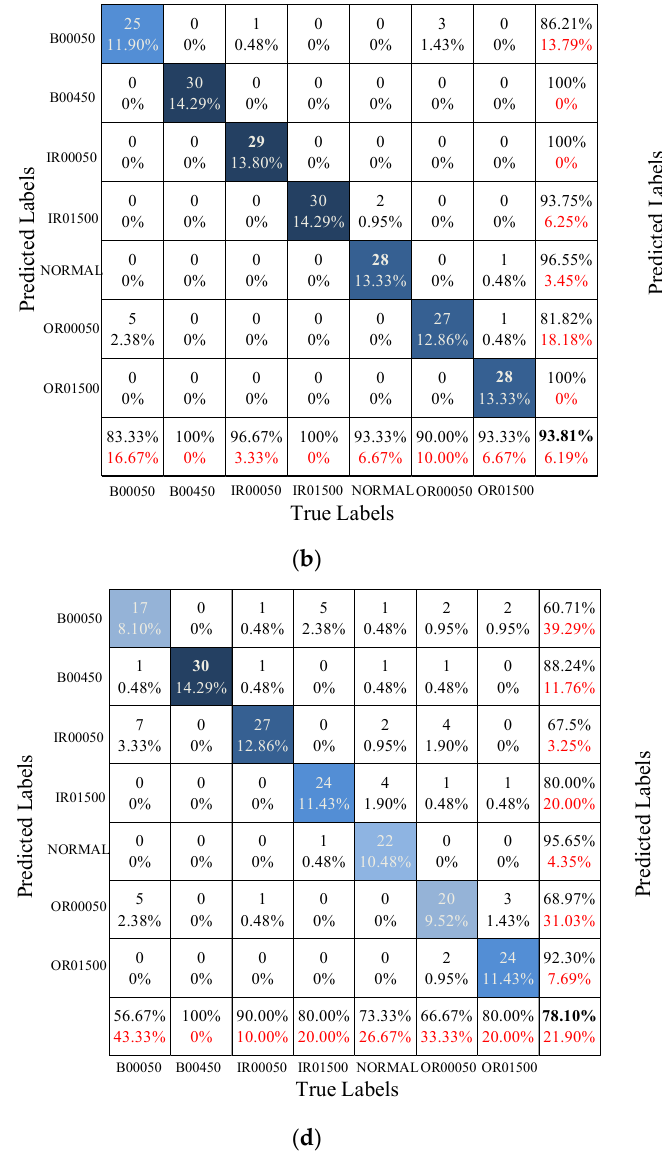
Figure 7. Confusion matrix charts of fault diagnosis results obtained by different approaches: ( a ) ResNet34 ‐ TL; ( b ) MobileNet ‐ TL; ( c ) ResNet34; ( d ) MobileNet; ( e ) CNN.